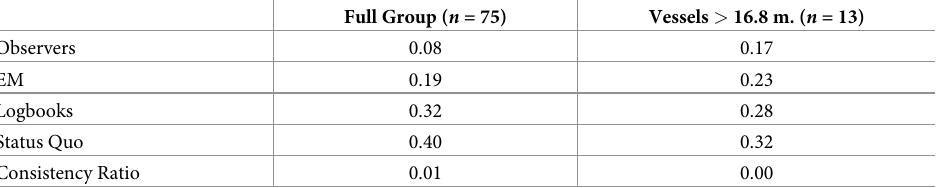
Table 4. Weight of preference among full interview group compared with subgroup of interviewees fishing on ves- sels greater than 16.8 m. in length, across human observers (‘Observers’), electronic monitoring (‘EM’), detailed logbooks (‘Logbooks’), and the status quo (‘Status Quo’) alternatives for data collection at